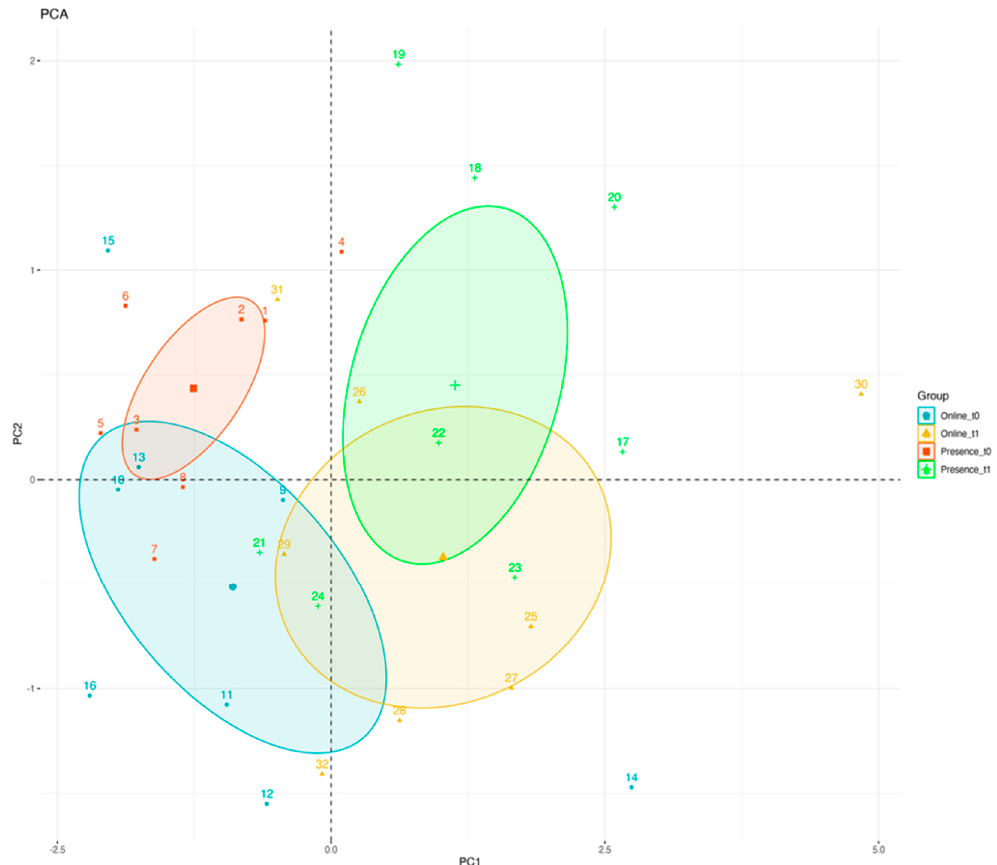
Figure 3. Principal Component Analysis Results. Principal component analysis of behavioral im- provements in socio-pragmatic skills as detected in the Experimental group (Online training) and Control group (in-presence training).